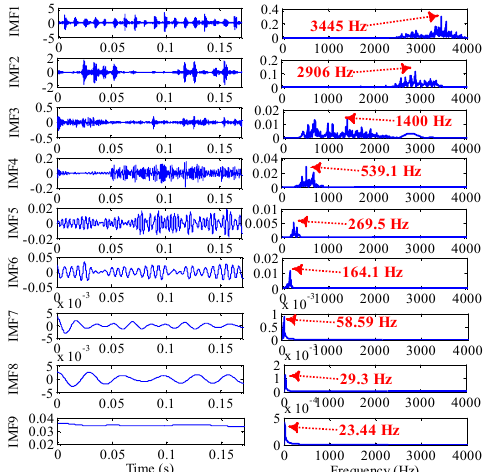
Figure 17. The IMFs of outer ring obtained by the optimized TVF-EMD method based on IGOA. Through the TVF-EMD method optimized by GOA, the signal is decomposed into 10 IMFs. The evaluation indexes of the decomposition results are shown in Figure 18 and Table 10. The EC and EE indexes of IMF9 and IMF10 obtained by GOA have increased, and their center frequencies are both 5.85 Hz, which indicates that over-decomposition and mode aliasing occurred during the decomposition process. Compared with the indexes obtained by GOA, the indexes of IMF1~IMF9 obtained by IGOA are larger, which indicates that the decomposition performance of IGOA-TVF-EMD is better than that of GOA-TVF-EMD. It can be seen from Table 10 that the difference in RMSE obtained by the two methods is very small, while the absolute value of the ELR index obtained by IGOA is smaller than that of GOA, which indicates that IGOA reduces the decomposition error and energy leakage. Table 10. Decomposition results evaluation of outer ring slight damage signal under different pa- rameters.